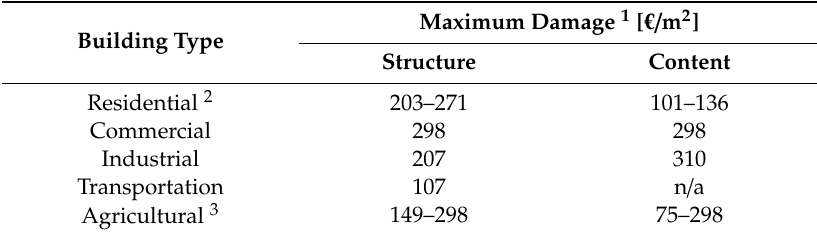
Table 2. Maximum damage values used in the